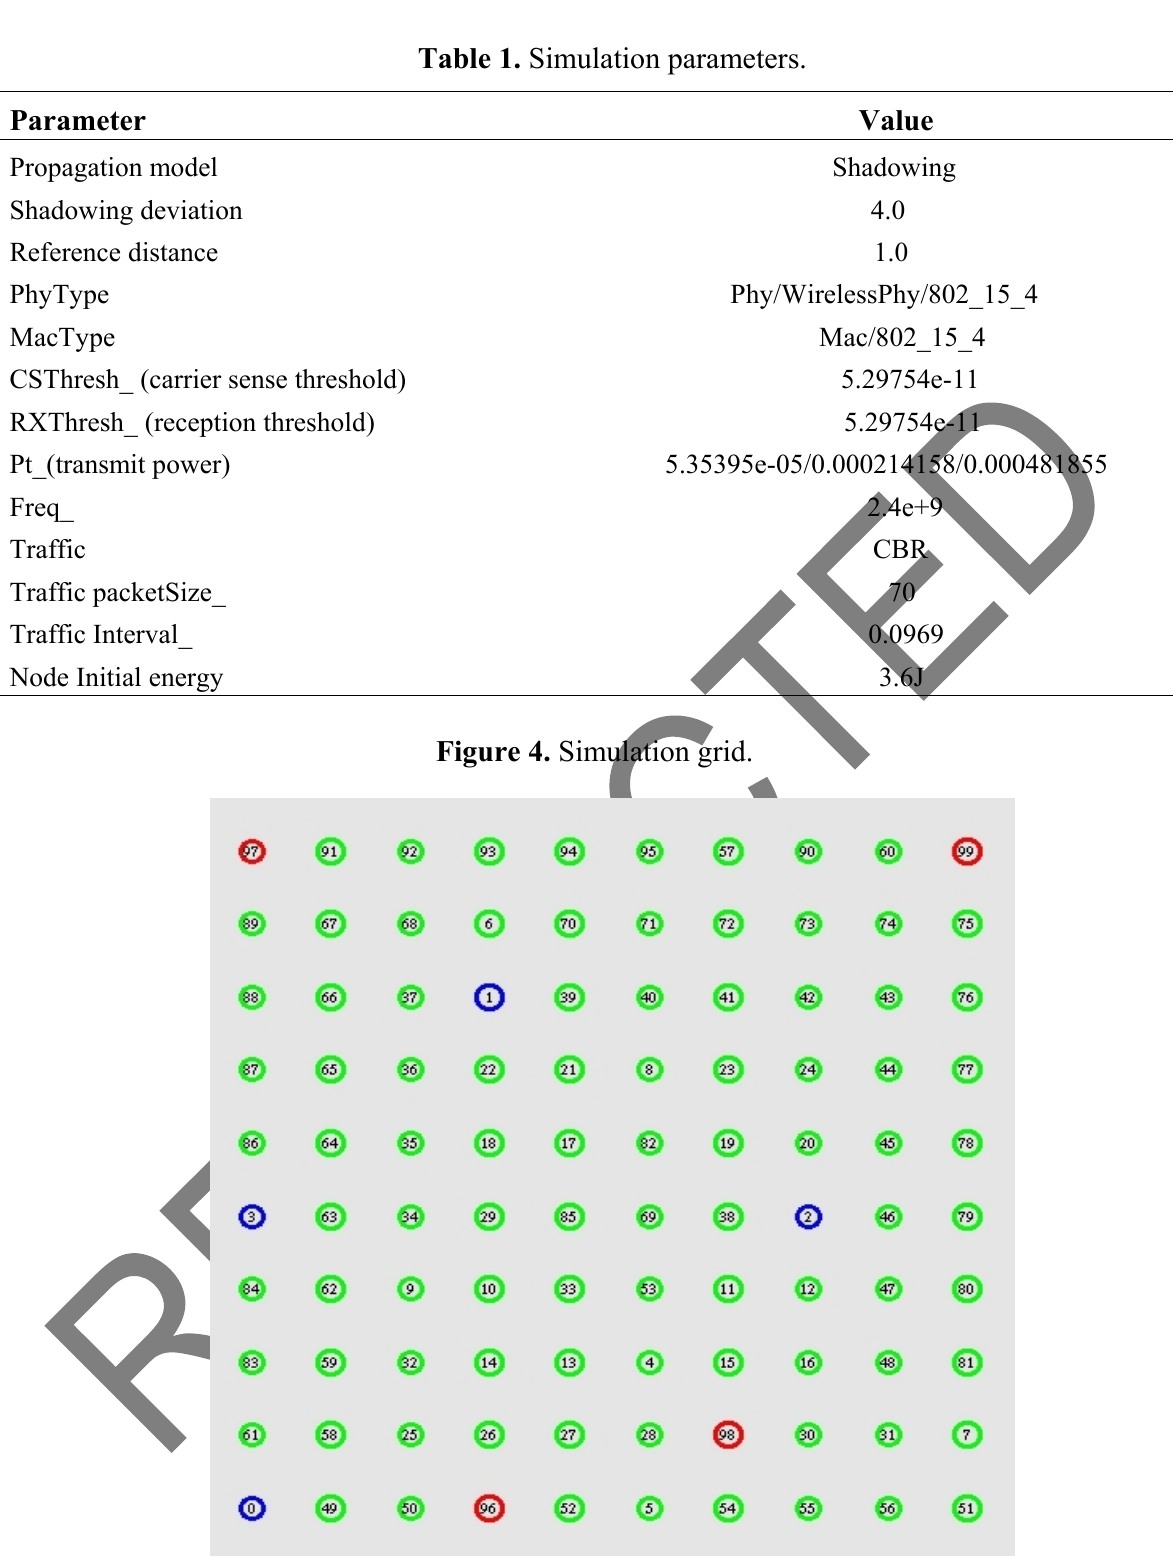
Table 1. Simulation parameters.